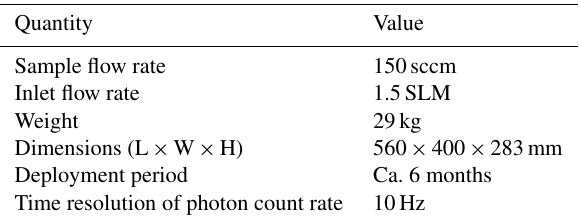
Table 2. IAGOS NO x instrument